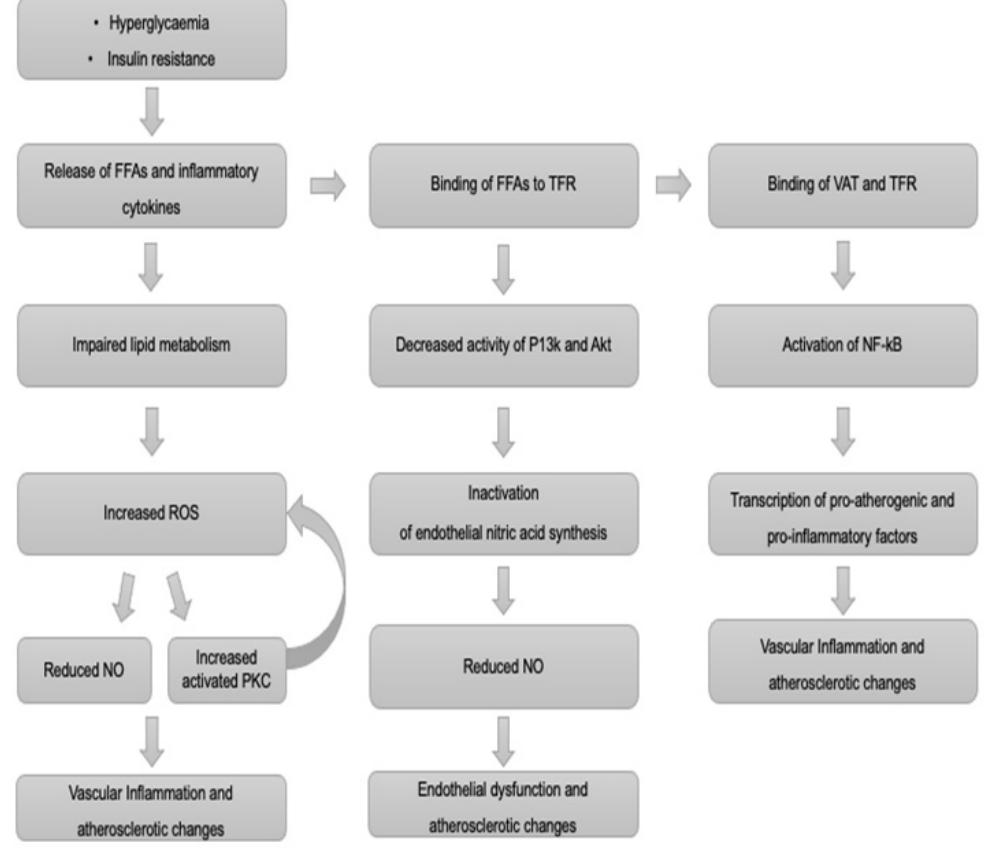
Figure 1. Main pathways that result in vascular inflammation, formation of atherosclerotic changes and endothelial dysfunction, culminating in increased stroke risk.